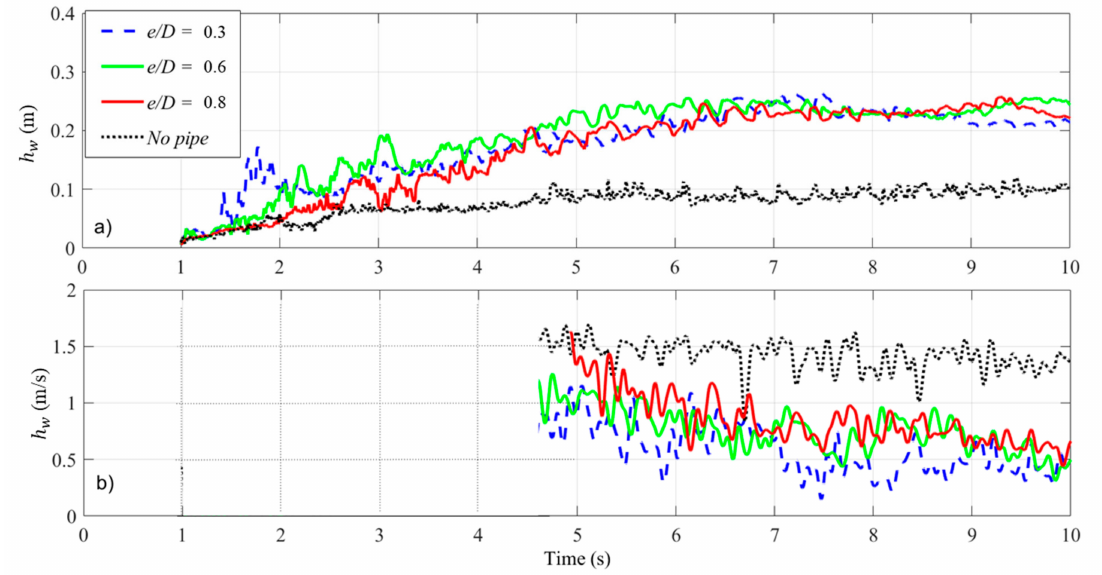
Figure 14. E ff ect of pipe existence in flow hydrodynamics for di ff erent e / D values, dry bed condition and h = 40 cm. ( a ) Water level time history and ( b ) flow velocity